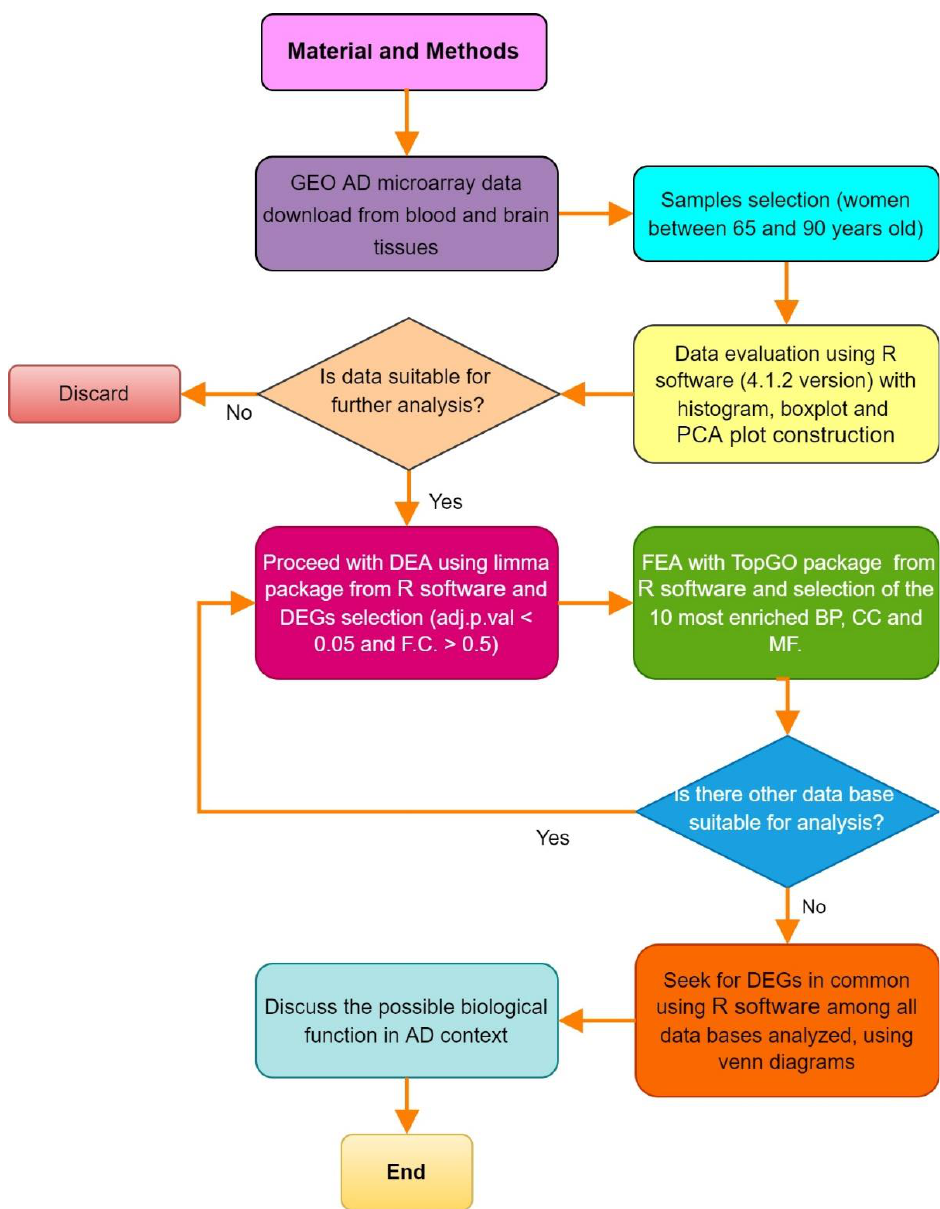
Figure 1 schematizes the bioinformatics analysis performed in this study. The down sections detail it to step by step.